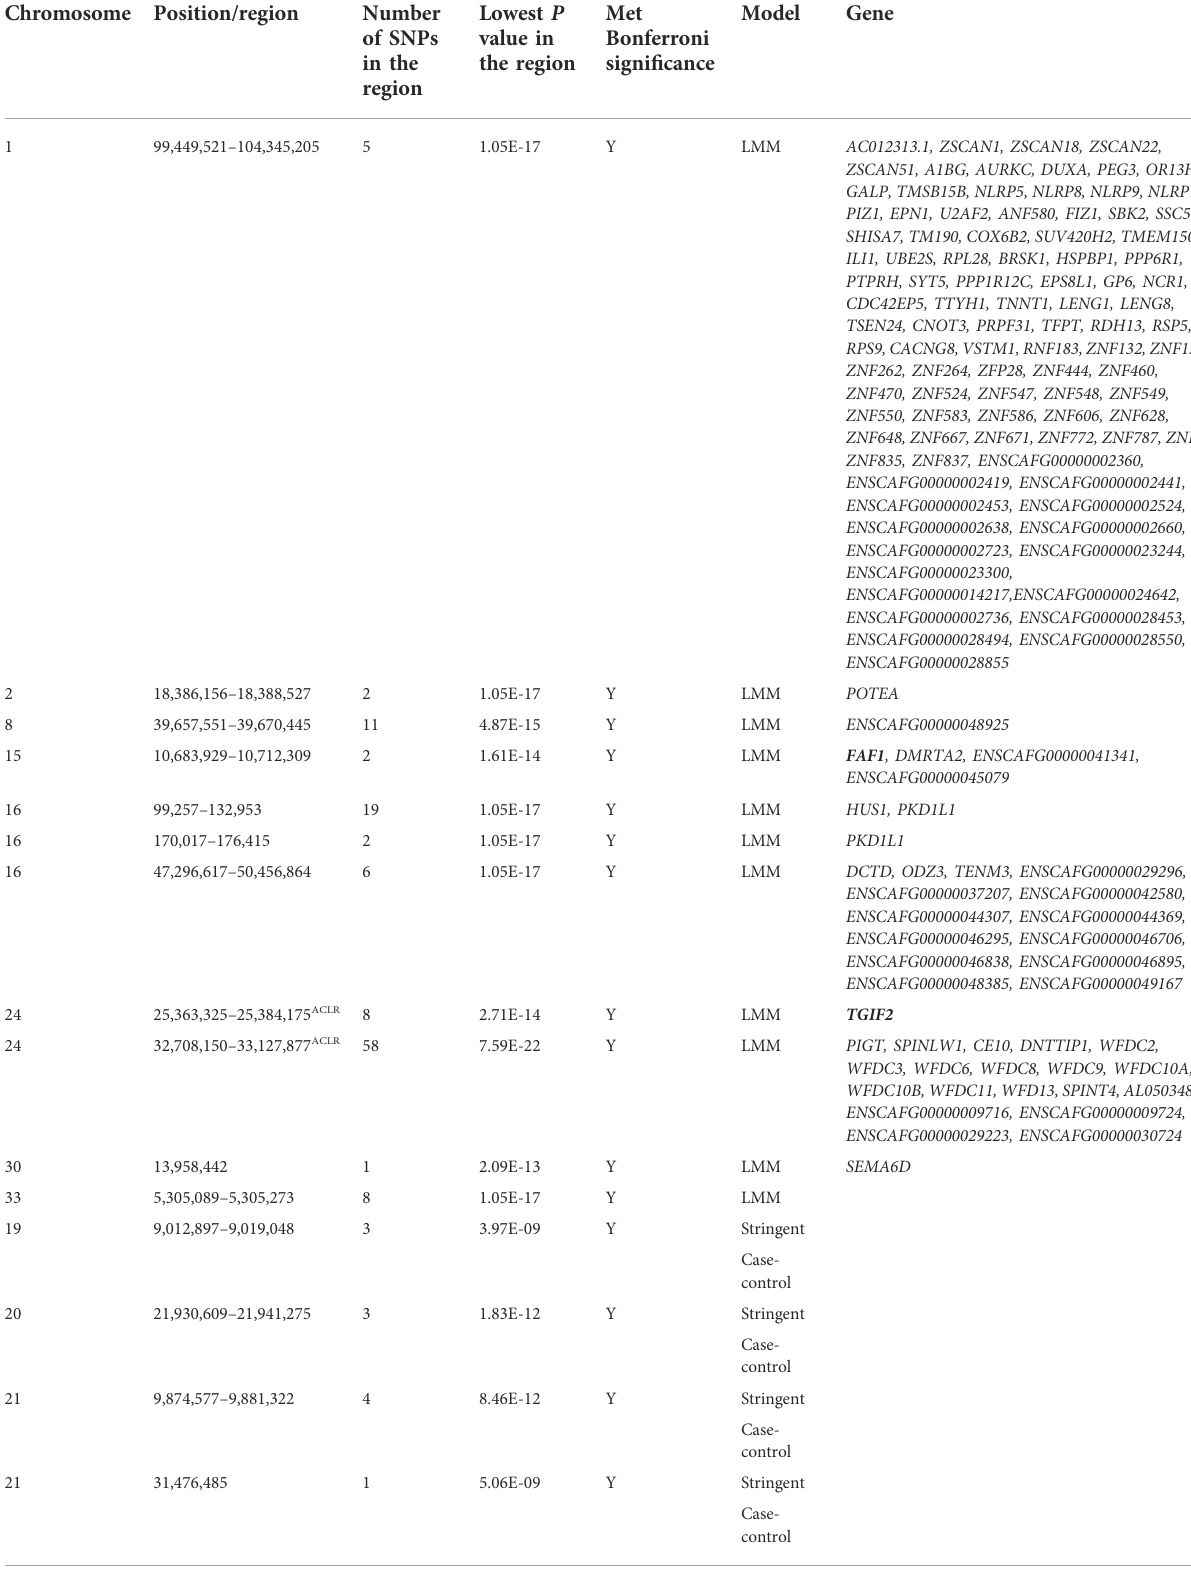
TABLE 4 Top candidate loci associated with elbow dysplasia in across-breed GWAS using breed phenotypes and four different association models. Chromosome